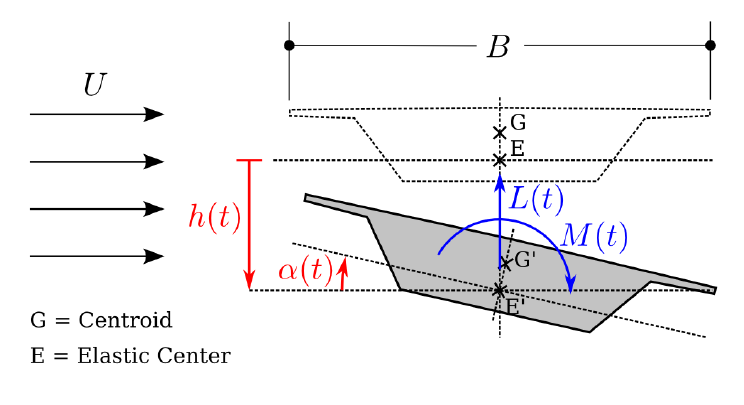
Figure 17. Schematic of the bridge section geometry. The reference system for generalized displacements and forces is also